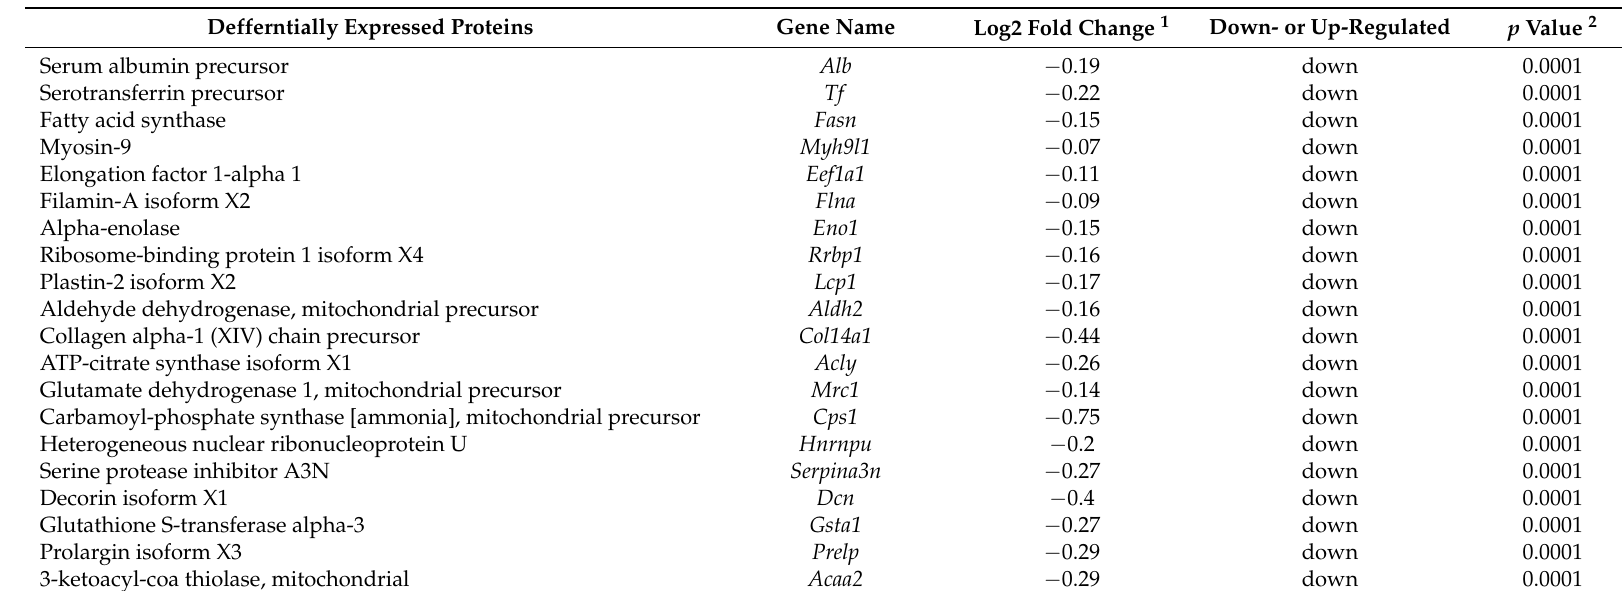
Table 3. Differentially expressed proteins with the Purple Carrots Diet in adipose